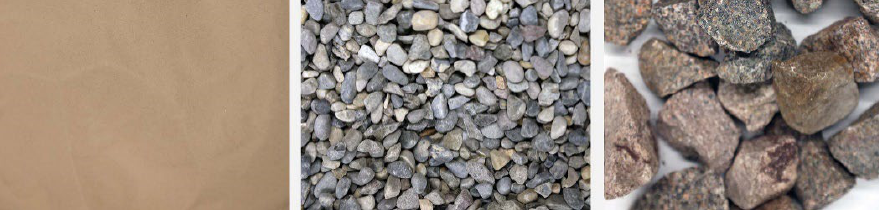
Fig. 1: Granular molding materials tested silica sand (0.1-0-2mm), small stones (2-5mm) and rocks (25-50mm) (left to right). Sand, gravel, and rocks demonstrate great results in heat resistance, recyclability, and removal